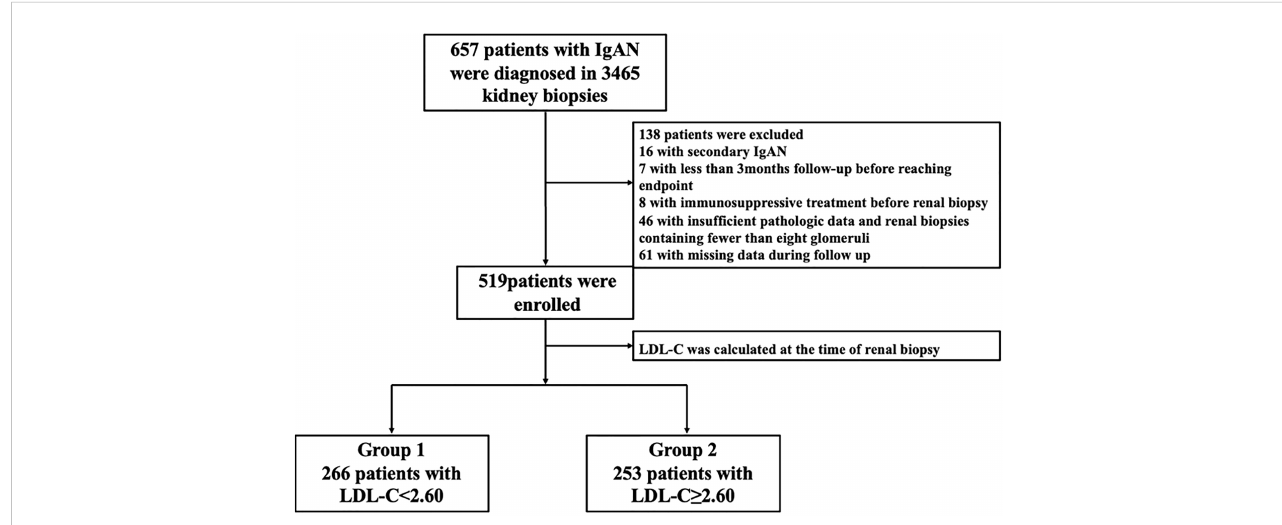
FIGURE 1 The selection process for patients in a fl ow chart. IgAN, IgA nephropathy; LDL-C, low-density lipoprotein